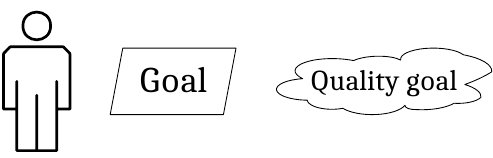
Figure 4. Selection of AOM notation elements.